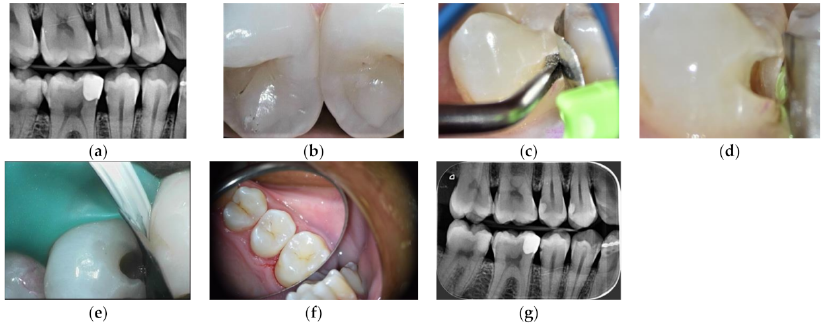
Figure 4. Slot cavity preparation on a distal carious lesion of an upper premolar restored with HV-GIC LC: ( a ) pre-operative radiograph; ( b ) marginal crest modification white spot (blue arrow); ( c ) US diamond insert half-round shape; ( d ) slot preparation; ( e ) metal matrix setting; ( f ) final occlusal view; ( g ) post-operative radiograph.